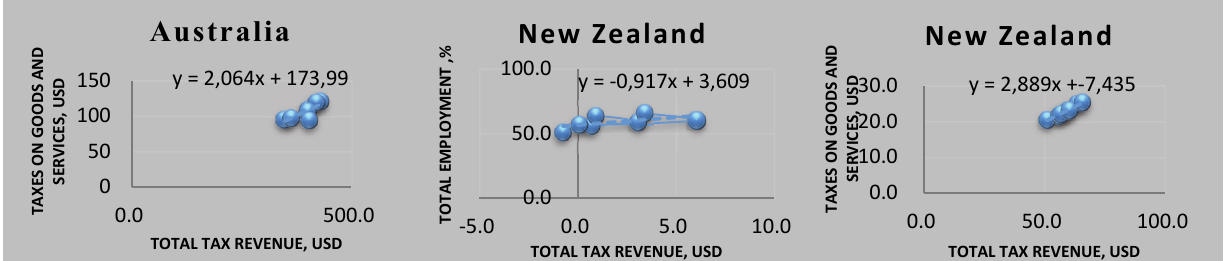
Fig. 4. Visualization of confirmed hypotheses in the form of linear equations